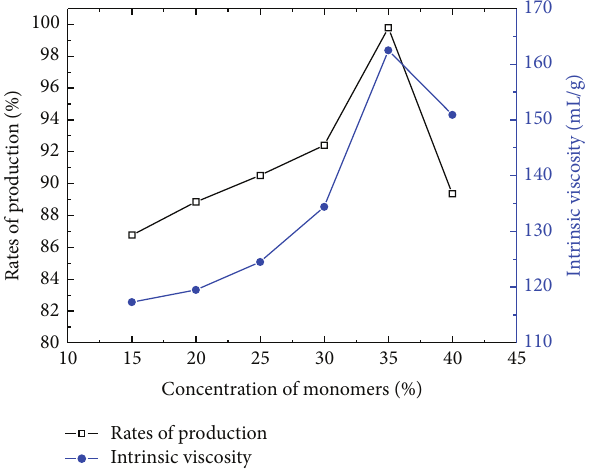
Figure 8: Effects of concentration of monomers on intrinsic viscosity and rates of production.